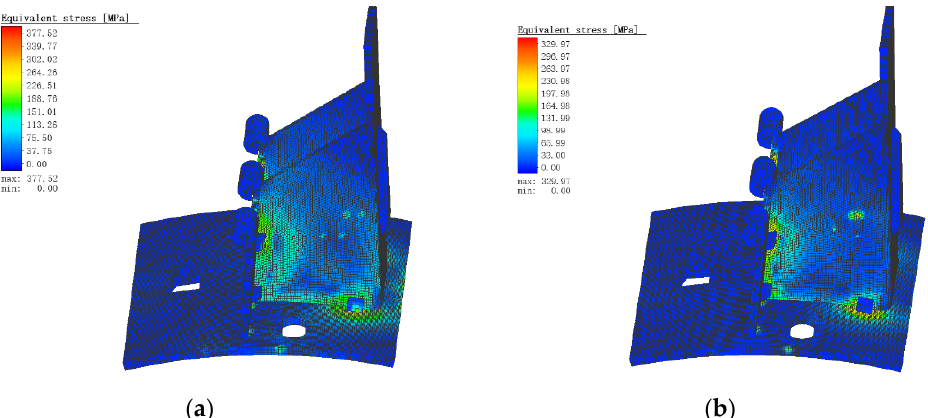
Figure 10. Equivalent stress diagram at the welding speed of 4 mm/s and 10 mm/s; ( a ) 4 mm/s; ( b ) 10 mm/s.